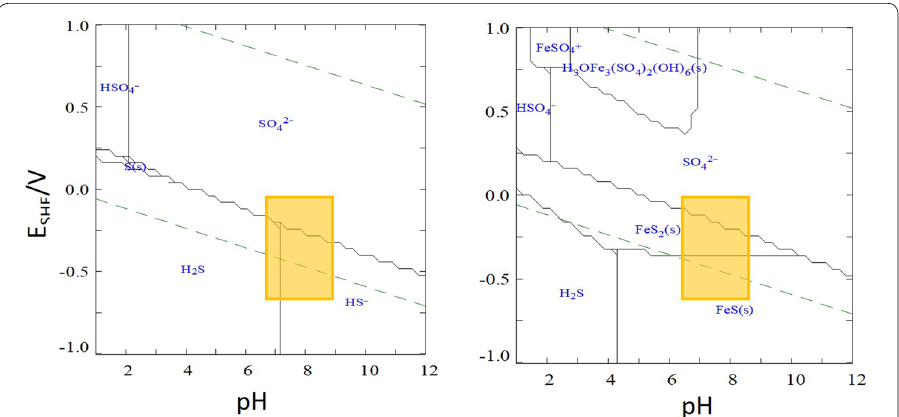
Fig. 11 Predominance diagrams as calculated by the code Hydra/Medusa code at room temperature (Puigdomenech, 2004). Left for the sulfur redox system and right for the iron–sulfur redox system. Concentrations of Fe and S are each 1 mM. Areas of relevance during the experiments are marked in yellow. The redox Eh is given in V referred to the standard hydrogen probe at 25